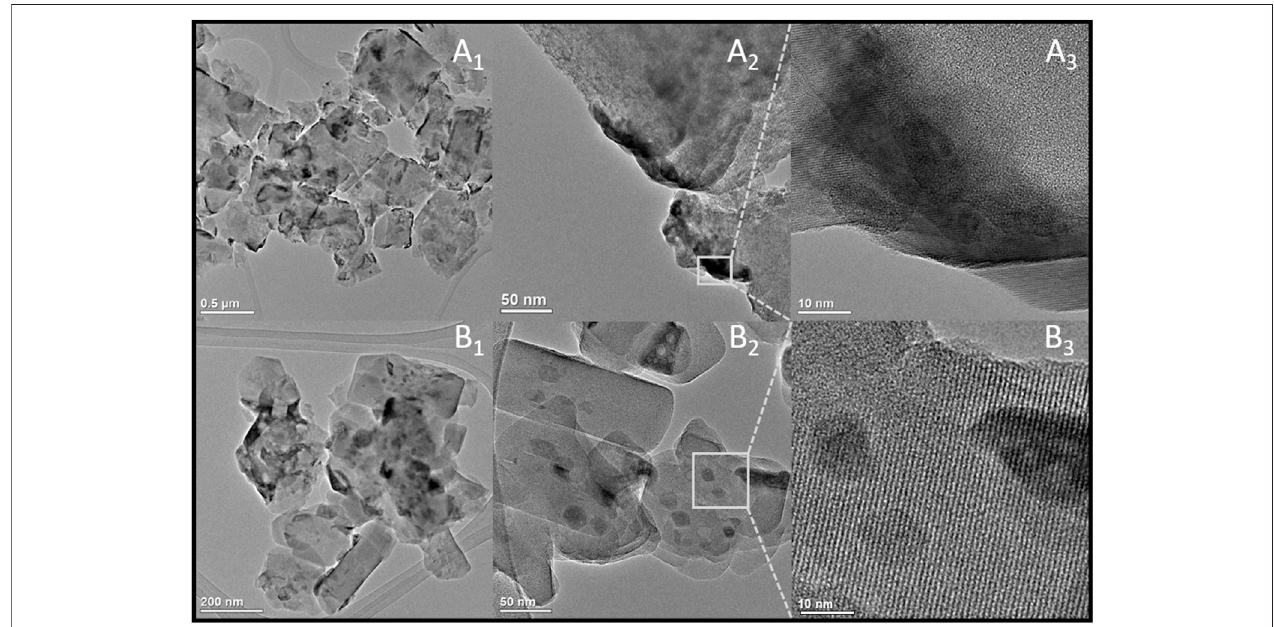
FIGURE 2 | HRTEM characteristics of the CoUSY (A 1 – A 5 ) and CoZSM-5 (B 1 – B 5 ) samples.